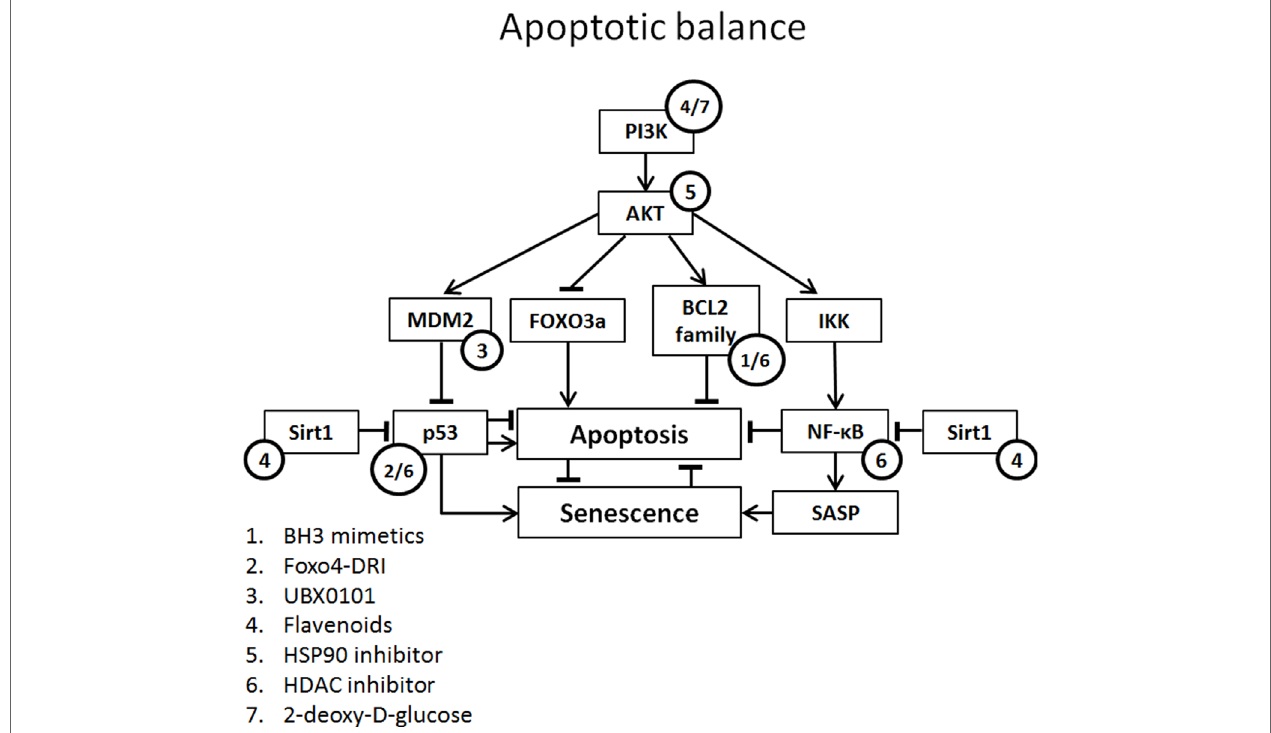
FIGURE 2 | Apoptotic balance of senescent cells with potential targets of senolytics. Apoptotic balance is influenced by a plethora of mediators. Abbreviations: FOXO3, forkhead box O3; IKK, I κ B kinase